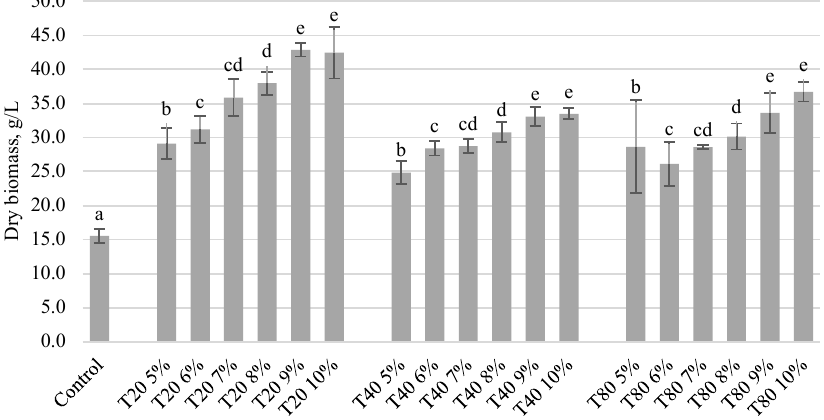
Fig. 5. R. glutinis biomass weight after 7 days of cultivation. The control sample without Tween is compared with the supplementation of Tween 20 (T20), 40 (T40) and 80 (T80) with concentrations 5–10 %. The letters a, b, c, d, e represent statistically significant differences between means of biomass weight on the 7 th day of cultivation, as a function of polysorbates